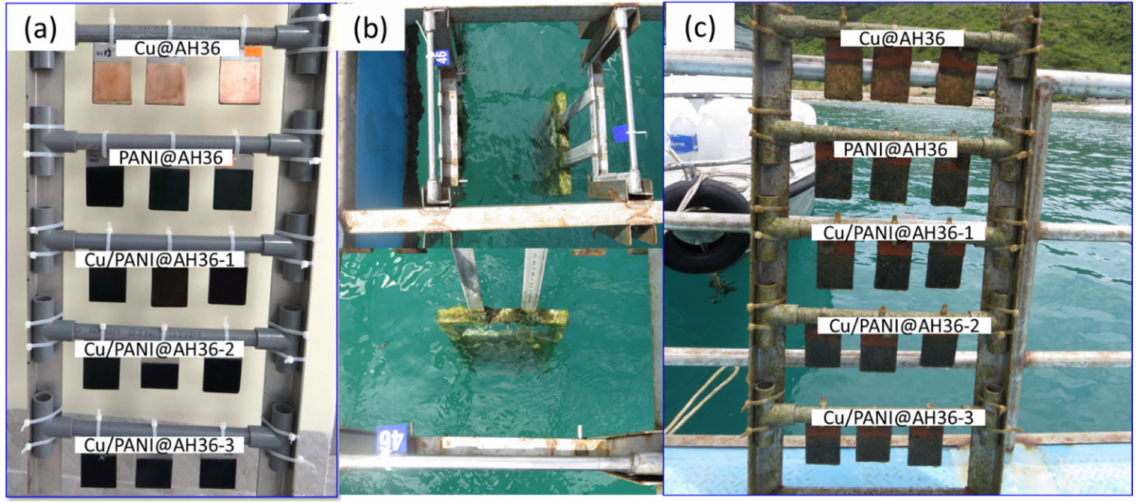
Figure 7. Photos of the different coated samples ( a ) before, ( b ) on-site, and ( c ) after exposure to seawater for 60